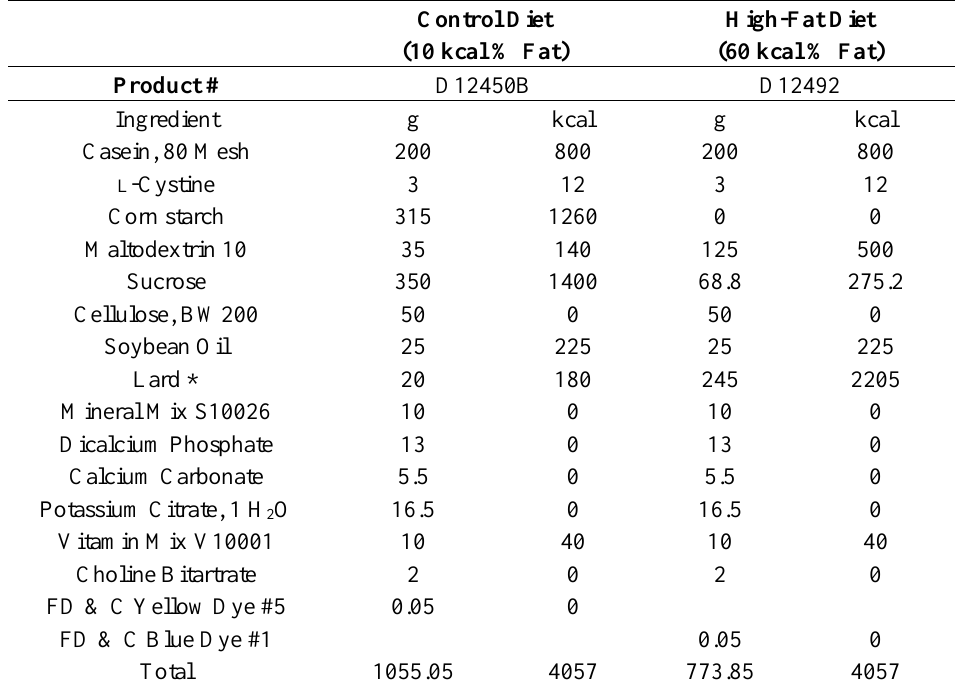
Table 1. Compositions of experimental